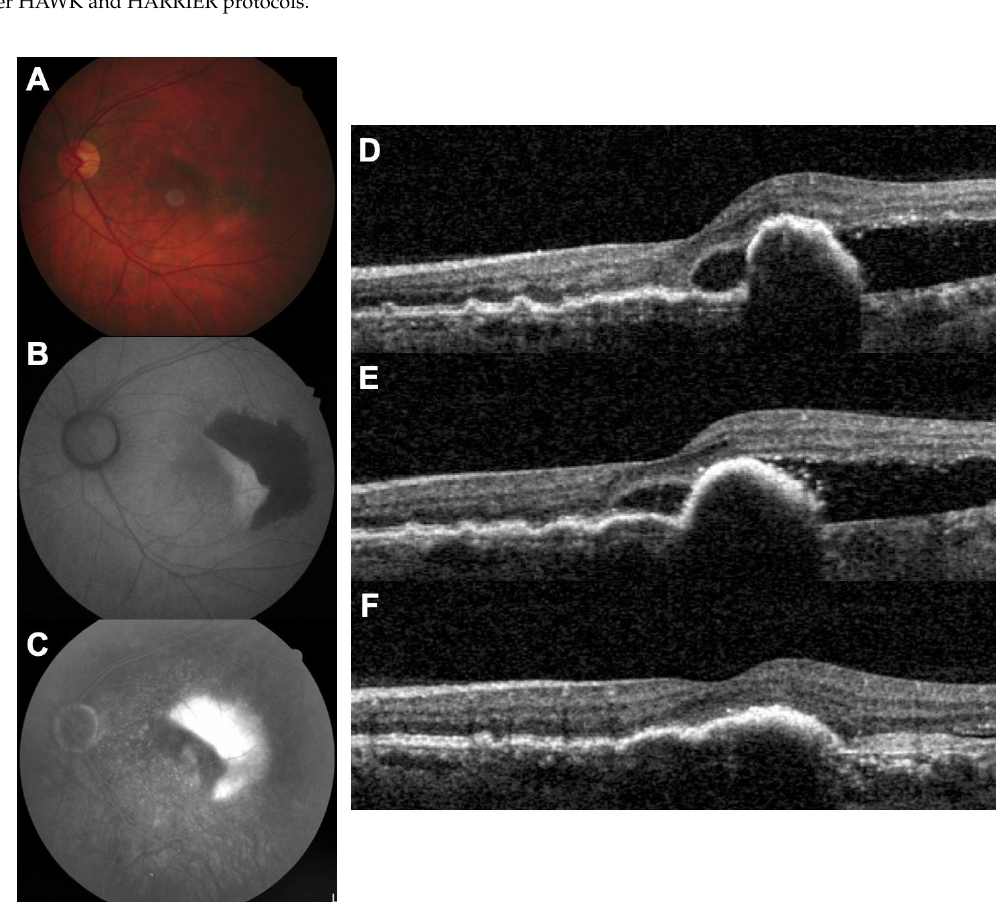
Table 1. Important characteristics of patients with pigment epithelial tears who received brolucizumab.